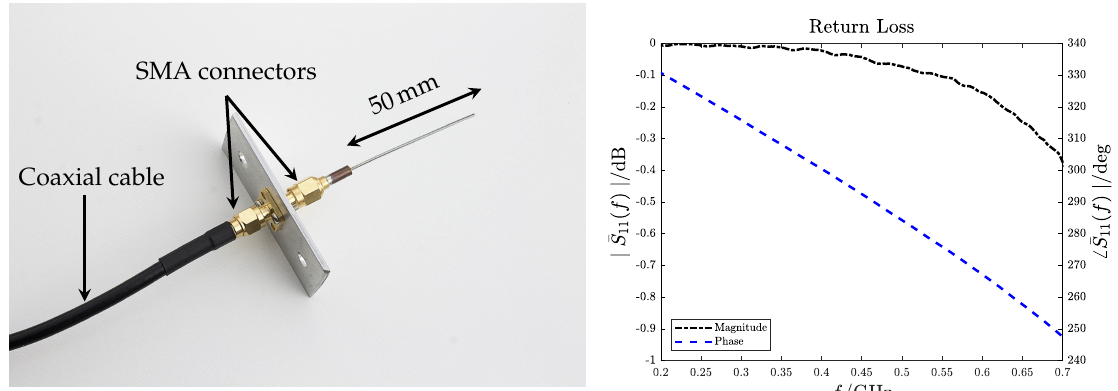
Figure 5. Monopole antenna.